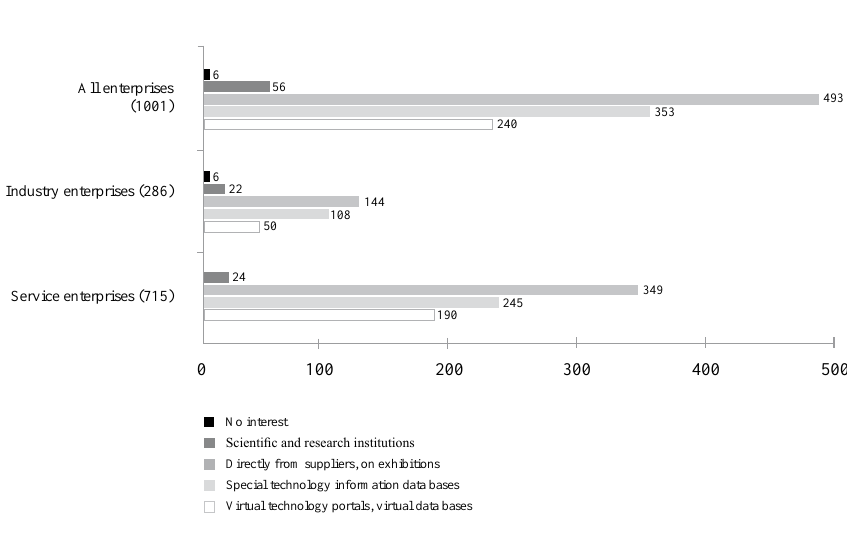
fig 9. Main sources of information about new